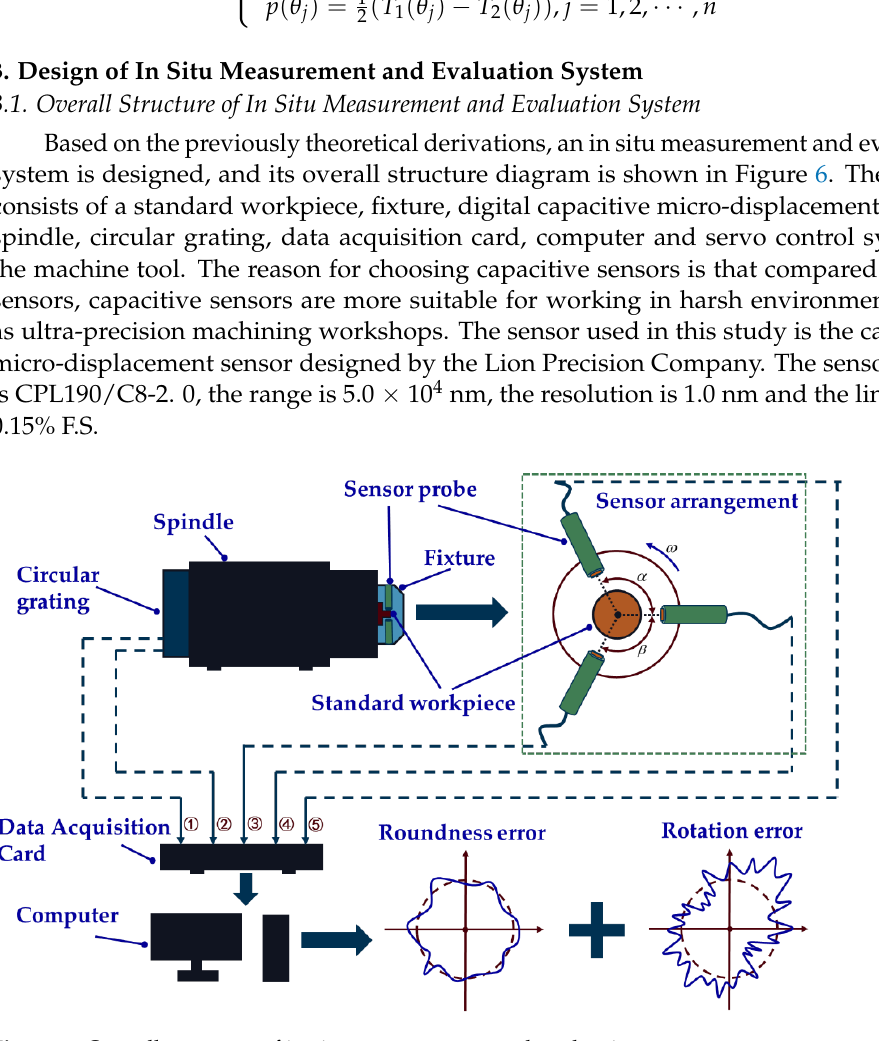
Figure 6. Overall structure of in situ measurement and evaluation